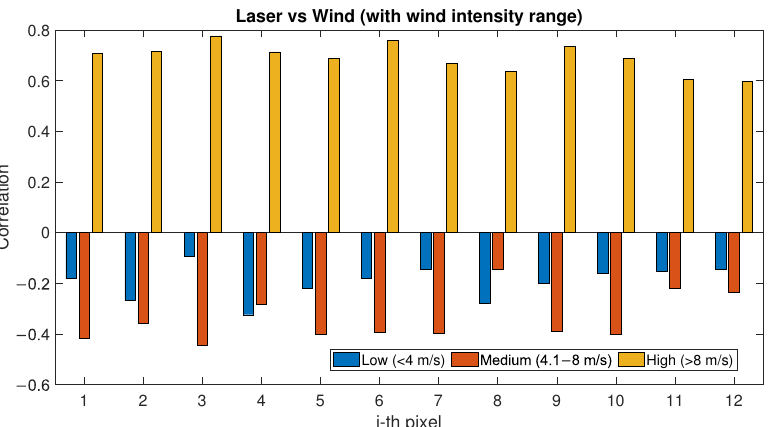
Figure 11. Correlation factor between PLS intensity and wind speed evaluated for low-, medium- and high-wind-speed conditions.